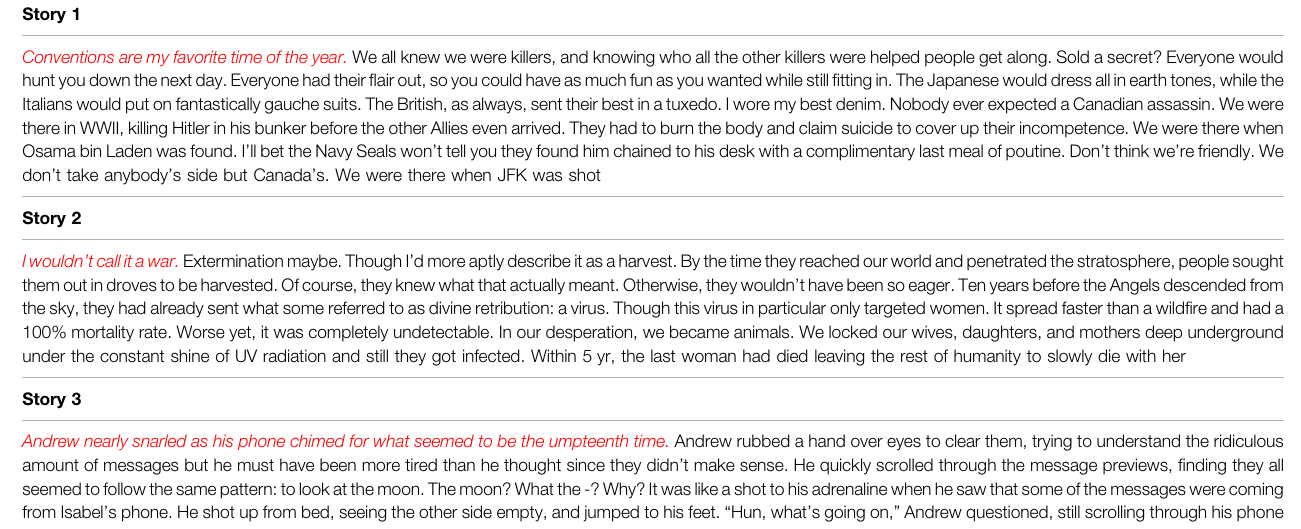
TABLE 2 | Example stories from r/WritingPrompts . Story starters are shown in